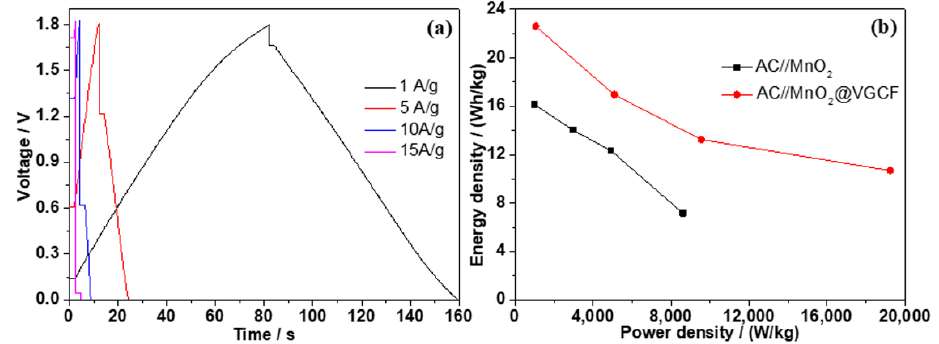
Figure 6. ( a ) Potential − time profiles of the AC//MnO 2 @VGCF electrochemical capacitor in 0.5 M K 2 SO 4 aqueous electrolyte and ( b ) Ragone plots of the AC//MnO 2 and AC//MnO 2 @VGCF superca- pacitors using 0.5 M K 2 SO 4 electrolyte.